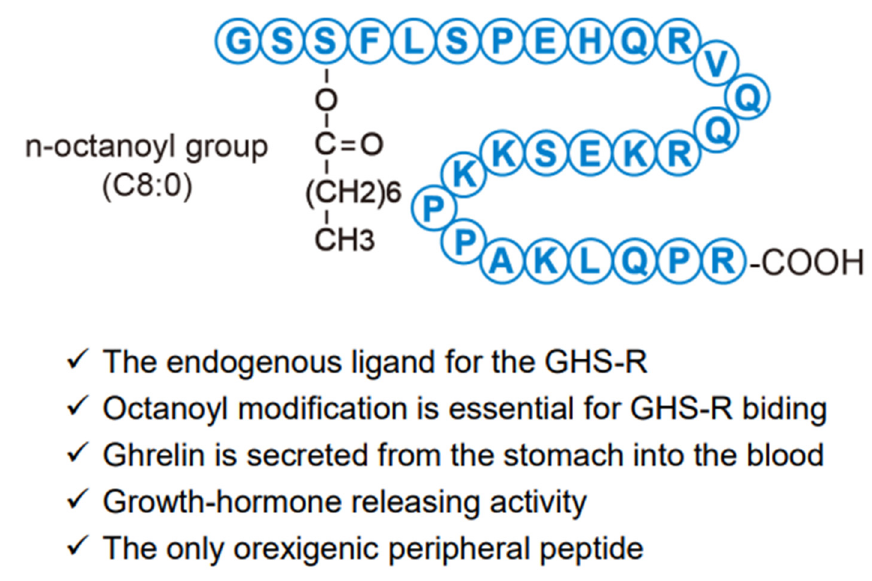
Figure 2. Structure and biological significance of human ghrelin.